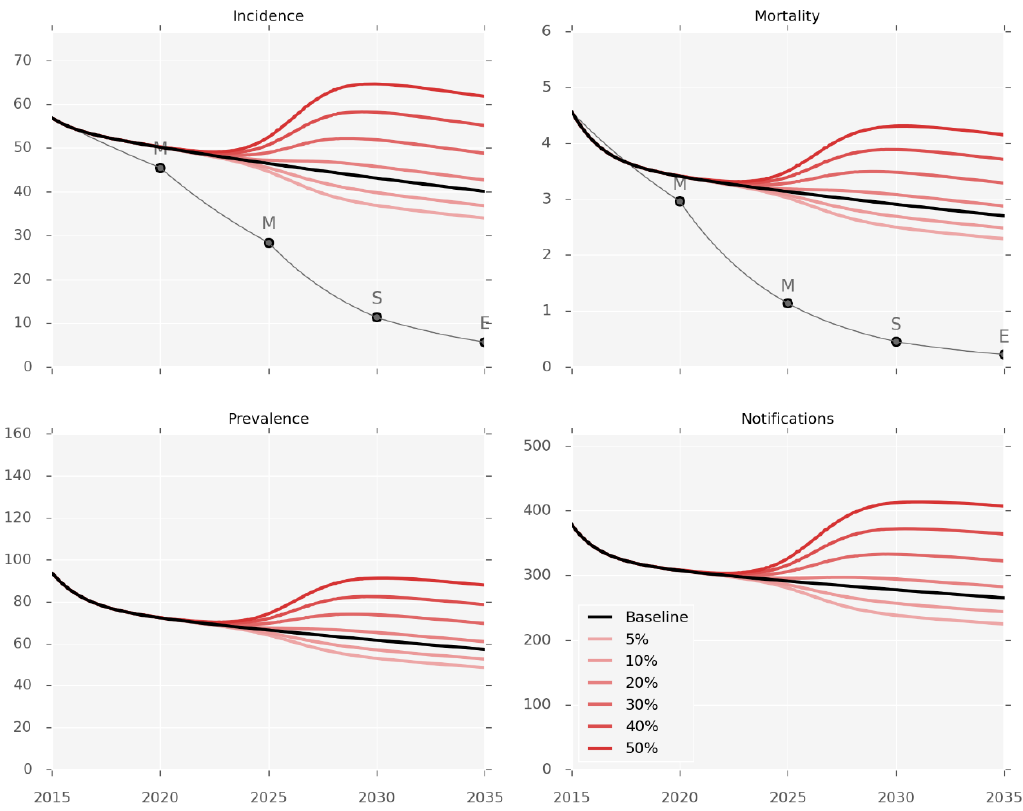
Figure 3. Diabetes prevalence counterfactuals. Incidence and observed mortality (per 100,000 per year), prevalence (per 100,000), and number of notifications by calendar year. Red lines represent the different levels of T2DM prevalence varying from 5% to 50%. The baseline scenario (15.6% T2DM prevalence) is shown in black.